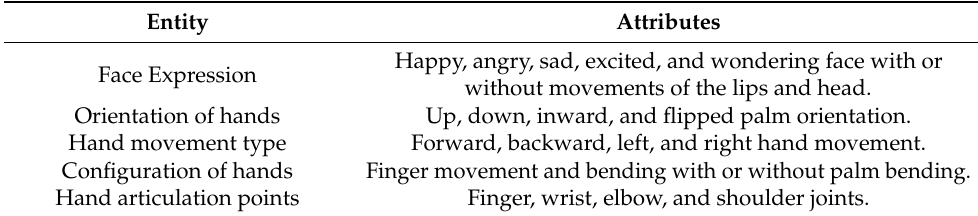
Table 1. Basic elements of sign language recognition. Entity Attributes Happy, angry, sad, excited, and wondering face with or Face Expression without movements of the lips and head. Orientation of hands Up, down, inward, and flipped palm orientation. Hand movement type Forward, backward, left, and right hand movement. Configuration of hands Finger movement and bending with or without palm bending. Hand articulation points Finger, wrist, elbow, and shoulder